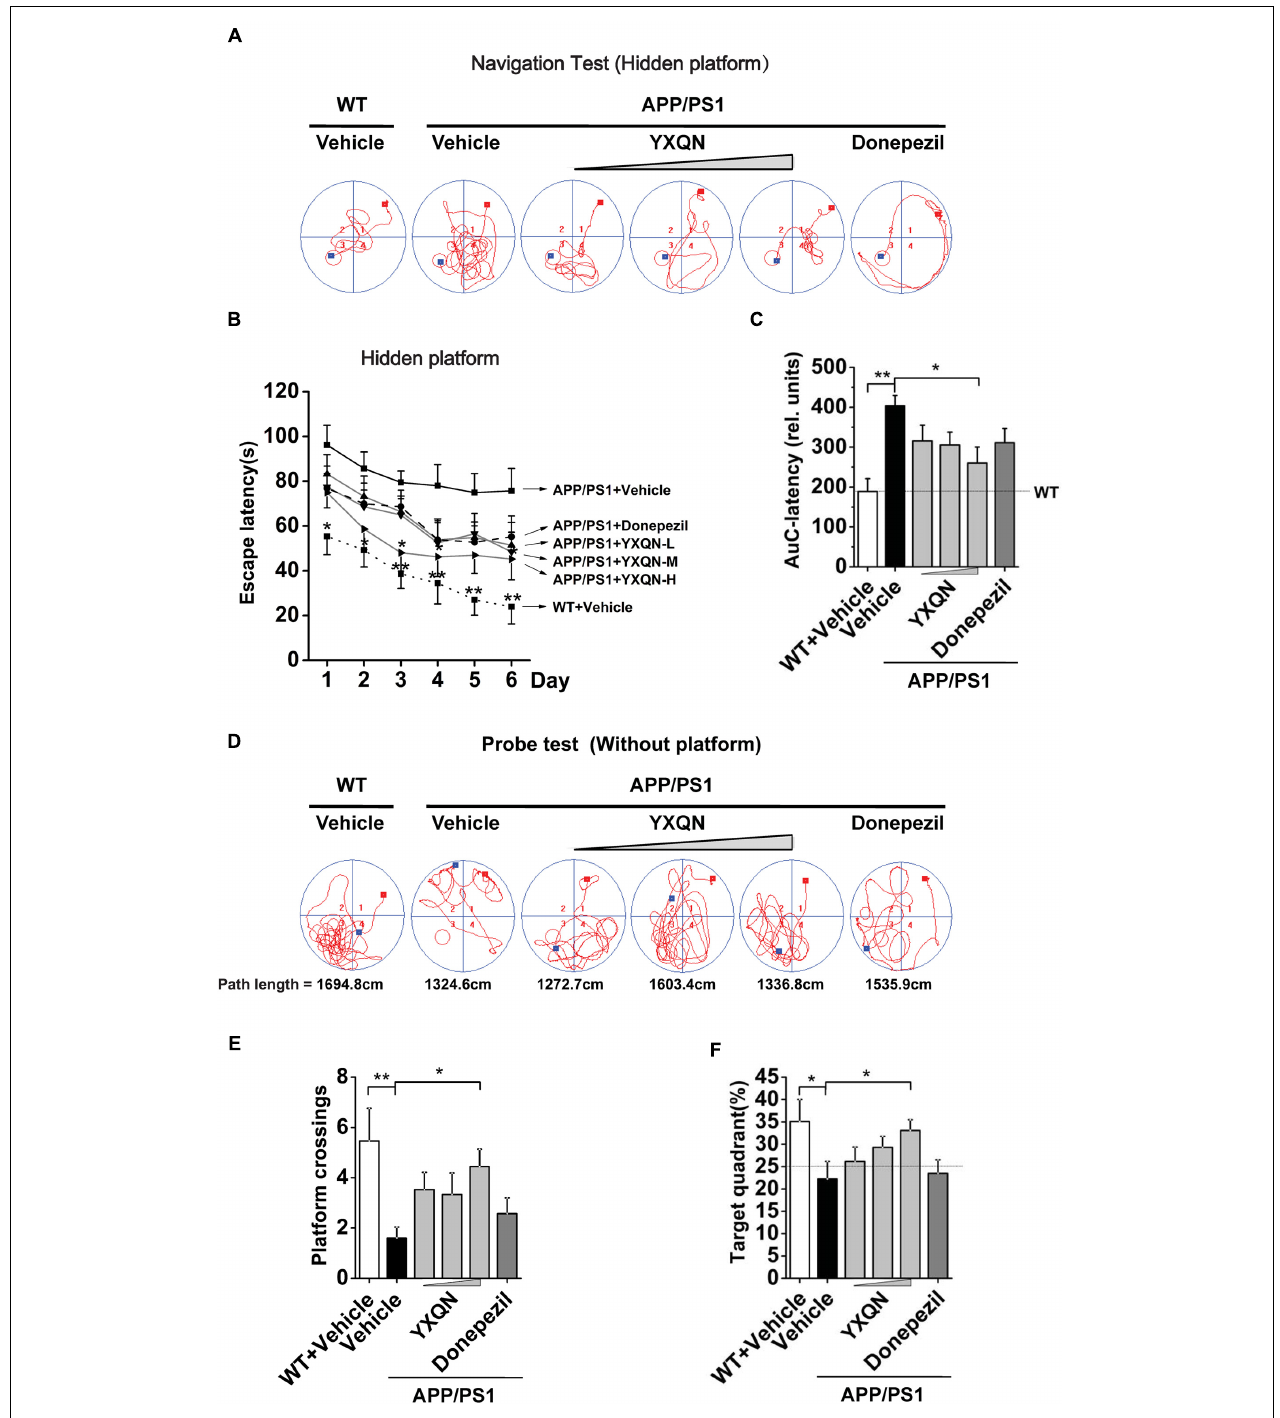
FIGURE 2 | Yangxue Qingnao improves the spatial and long-term memory decline in APP/PS1 mice by MWM. (A–C) Navigation tests analysis in MWM by escape latencies for WT mice ( n = 16) and the APP/PS1 mice with vehicle, YXQN extract or donepezil supplementation for 2 months ( n = 14–17). (A) Representative path tracking in the navigation tests with hidden platform. (B) Average latencies curve of four trials per day in the six consecutive days. (C) The area under the curve (AuC) of the escape latency was calculated for each group for statistical comparison. (D–F) Probe tests analysis of individual groups utilized MWM on day 7. (D) Representative path tracking in the probe tests without hidden platform. (E) The average times that the mice crossed platform location in 120 s. (F) The percentage of searching time that the mice of individual groups spent in the target quadrant where the platform has been located in days 1–6. The drug dosages are YXQN low-dose (YXQN-L) at 0.69 g/kg, YXQN middle-dose (YXQN-M) at 2.08 g/kg, and YXQN high-dose (YXQN-H) at 6.24 g/kg. Data are represented as group mean ± S.E.M. All post hoc statistical comparisons are versus the vehicle APP/PS1 mice, ∗ p < 0.05 and ∗∗ p < 0.01 (Dunnet’s post hoc ).